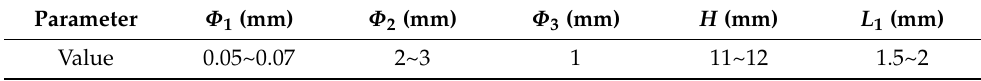
Table 1. Geometric dimensions of the coreless motor’s winding in Figure 1a .